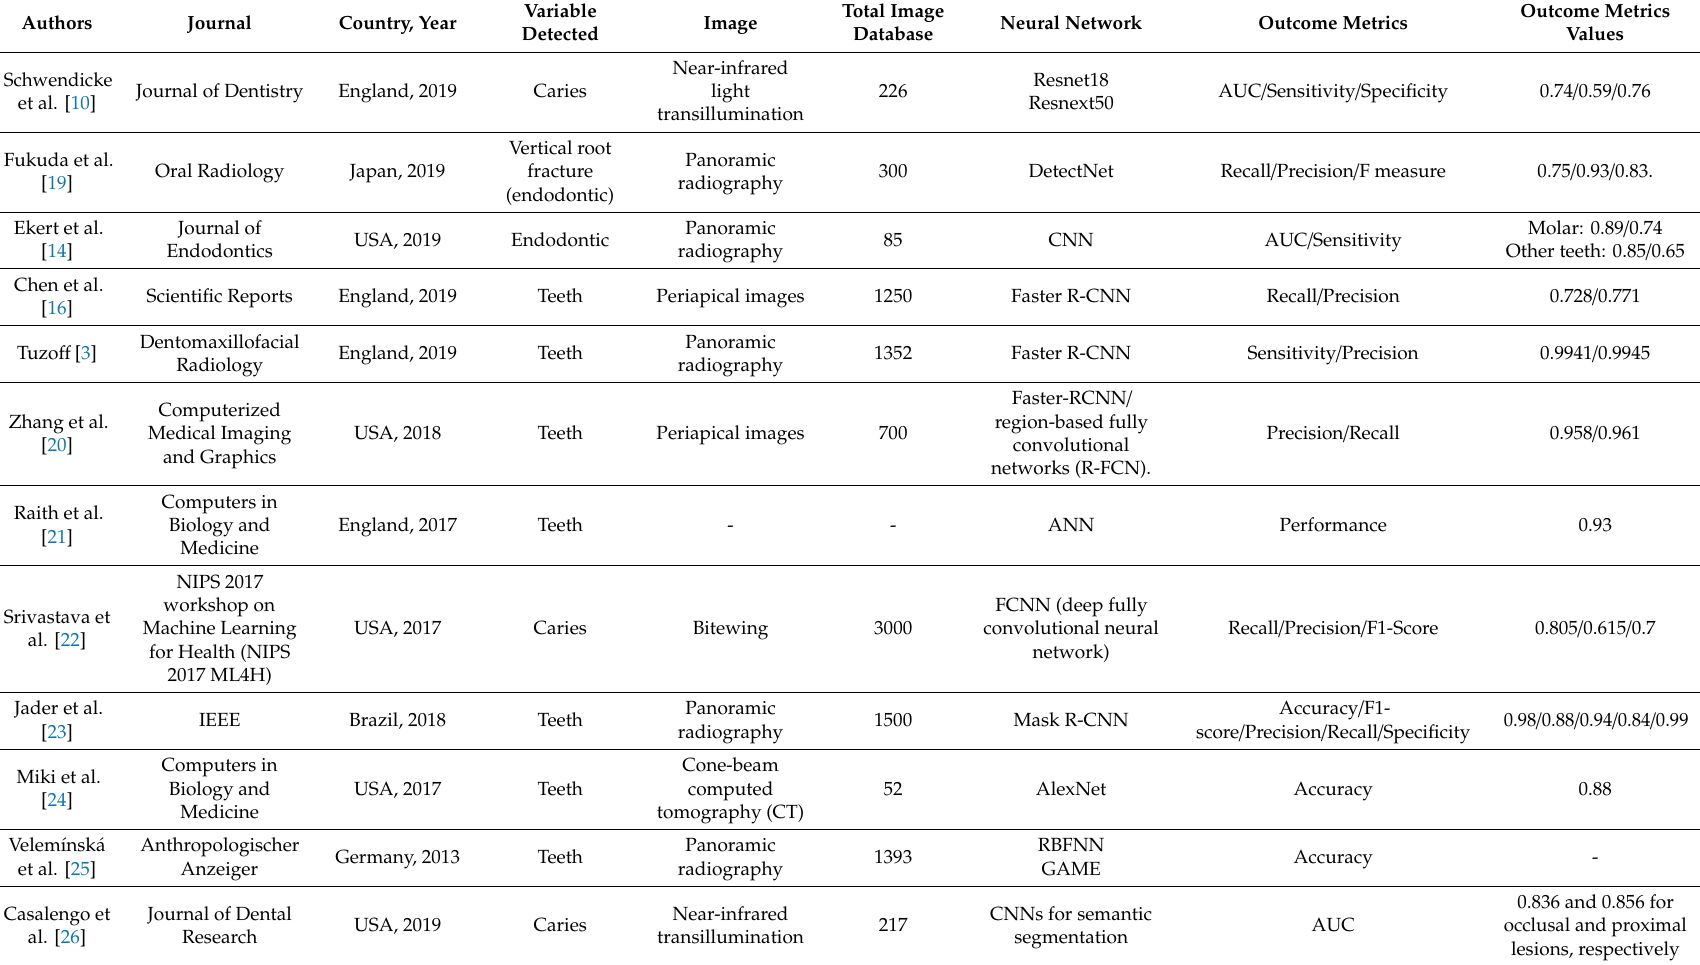
Table 2. Main characteristics of included